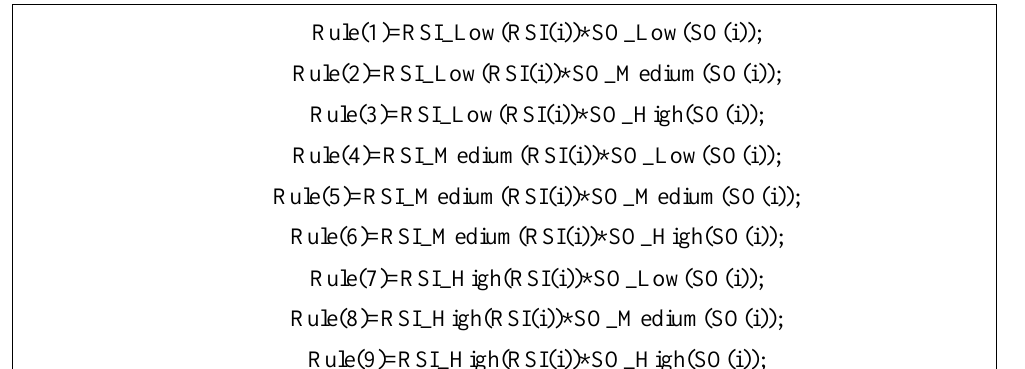
Table 2. The values of nine existing LHS in the rules